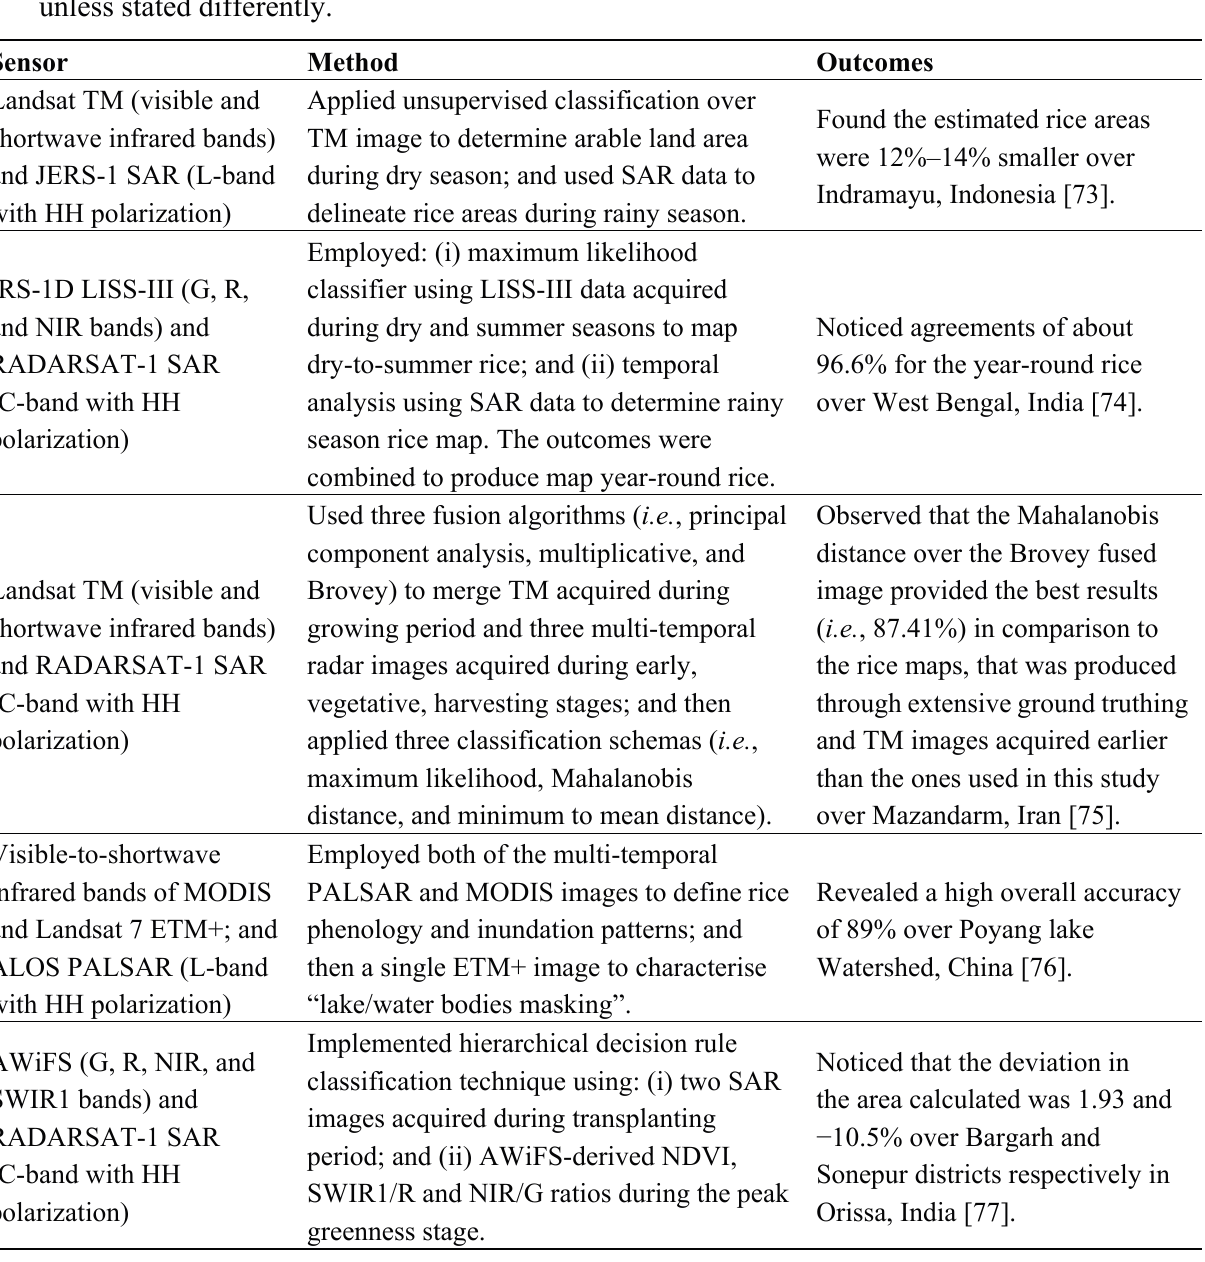
Table 4. Examples of integrating the optical and microwave imagery remote sensing data in mapping rice areas; which were usually evaluated against the agricultural statistical dataset unless stated